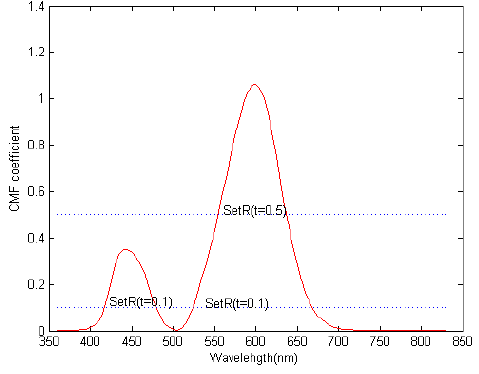
Figure 4. Color matching function (CMF) coefficient changes of red light .